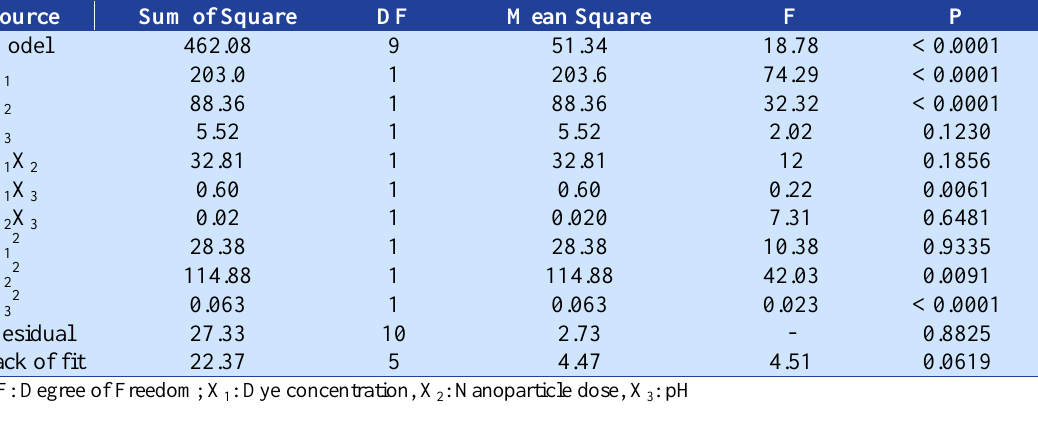
Table 3. ANOVA result of the quadratic model of photocatalyst degradation of acid black 1 using copper oxide doped zinc oxide